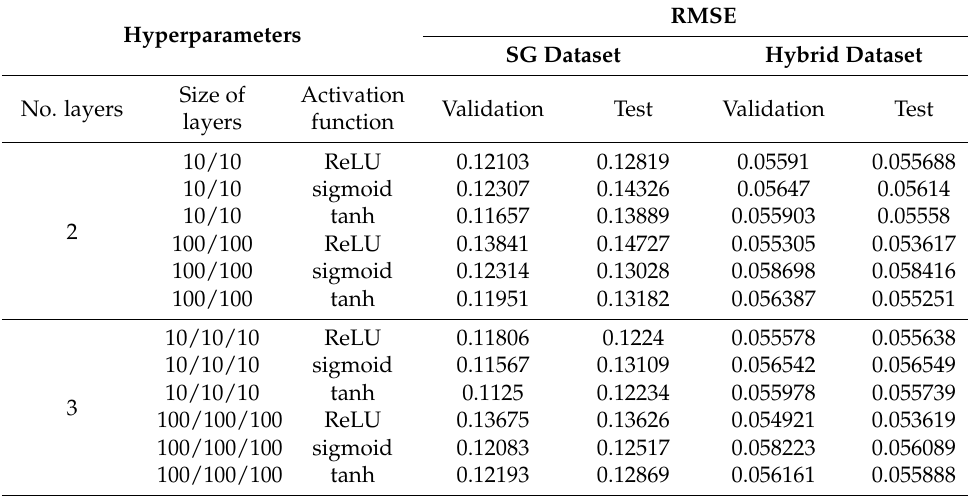
Table 5. Obtained RMSE values corresponding to different trained NN models with both experimental and hybrid